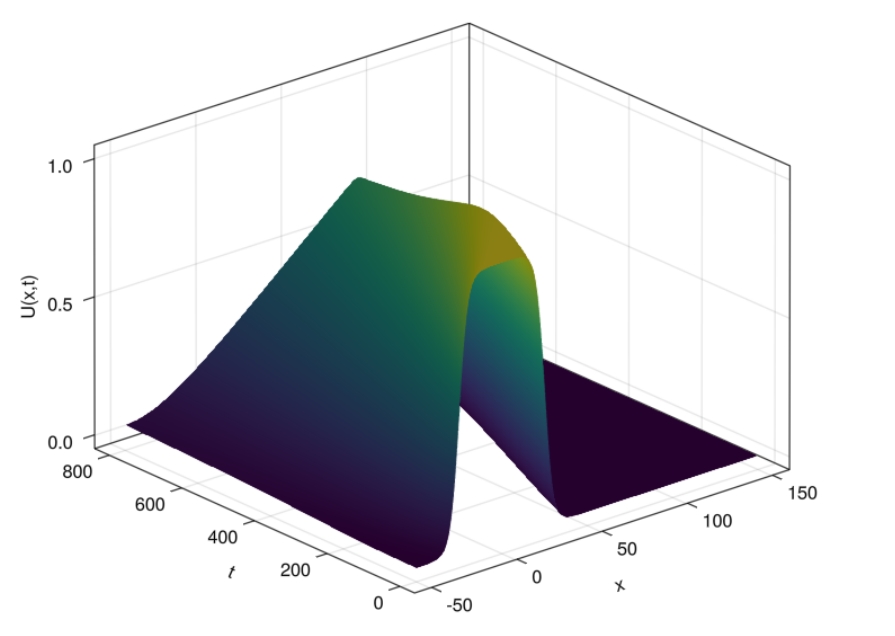
Figure 13. 3D plot for N = 300, t =